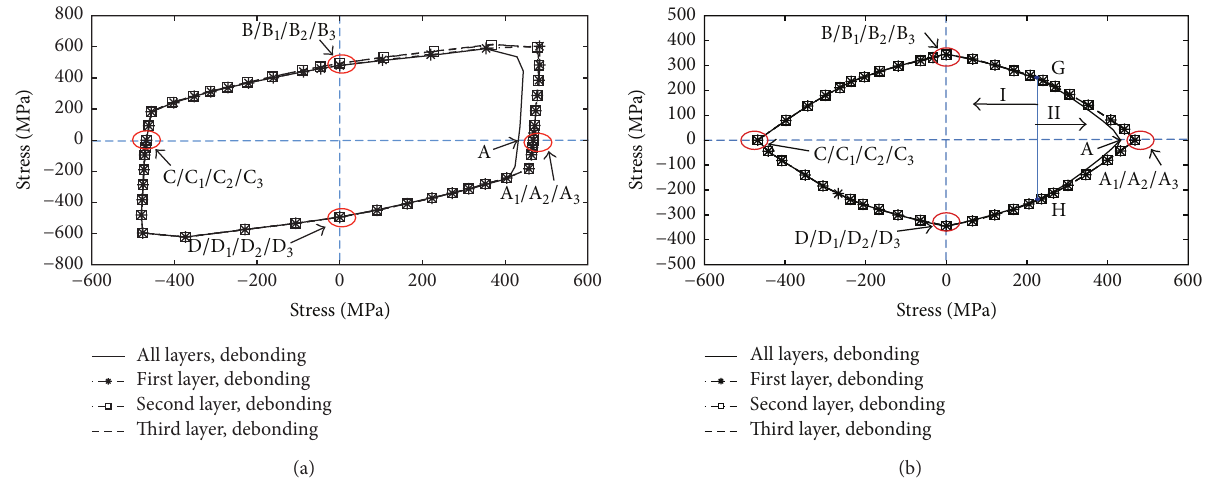
Figure 6: The failure envelopes of [0/ ± 45/90]